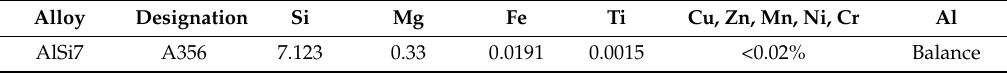
Table 1. Chemical composition (wt %) of the investigated Al – Si